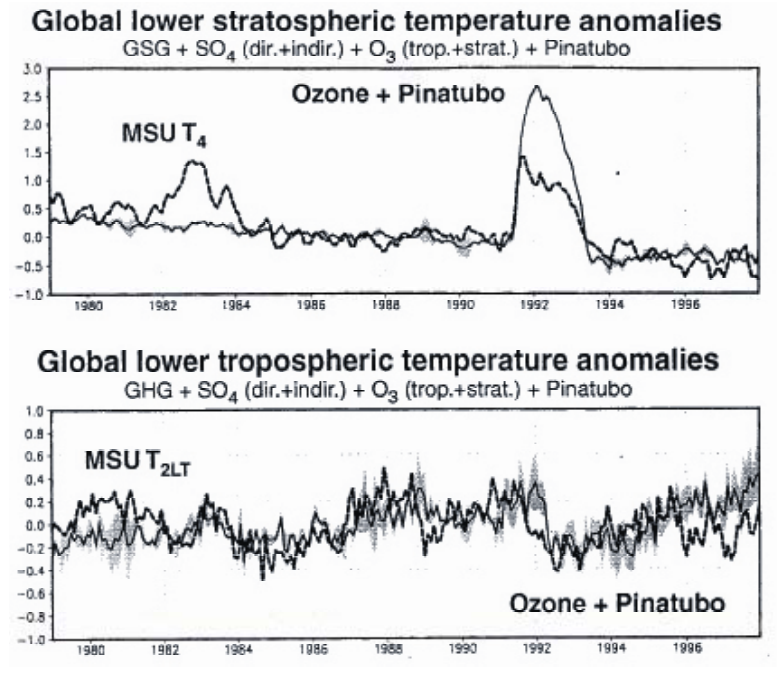
FIGURE 29. Comparisons of model results with satellite observations for lower stratosphere (top) and mid-troposphere (bottom). Dashed lines are observations, solid model are results and shading indicates range of the ensemble runs. Note agreement between MSUT2LT after Pinatubo (1991 till